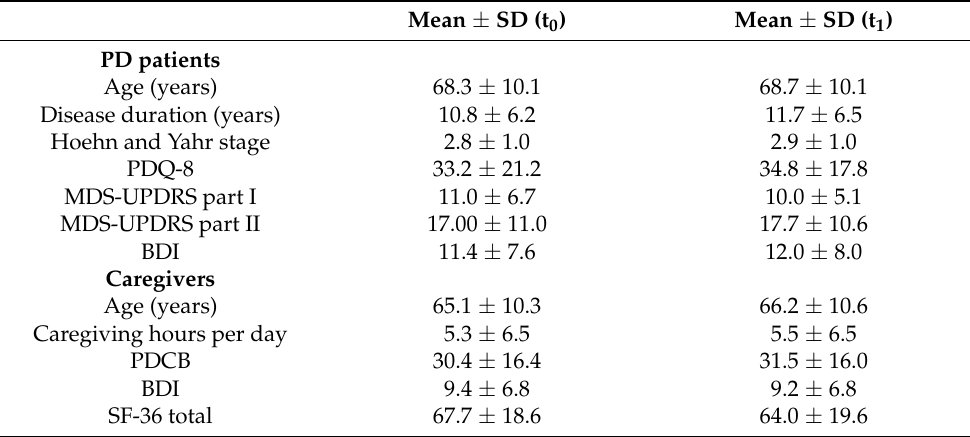
Table 1. Patient ( n = 89, n = 34 females) and caregiver ( n = 84, n = 54 females) characteristics.